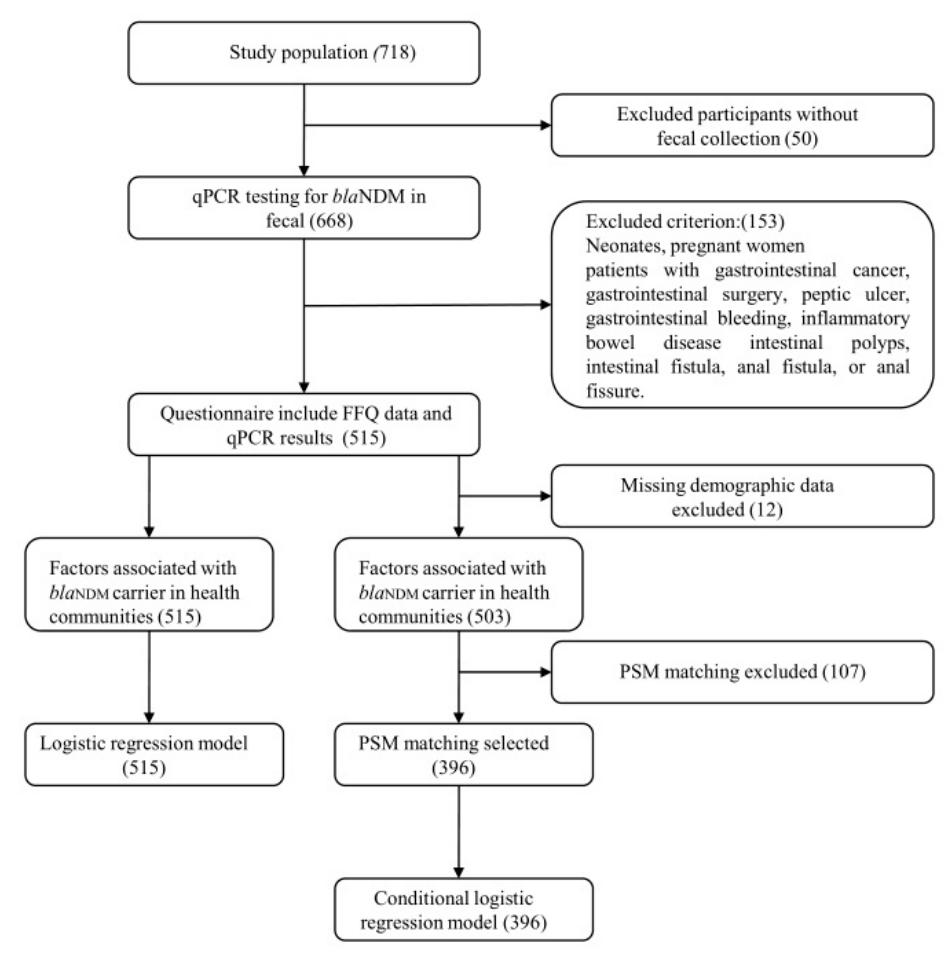
Figure 1. Flowchart of the study.